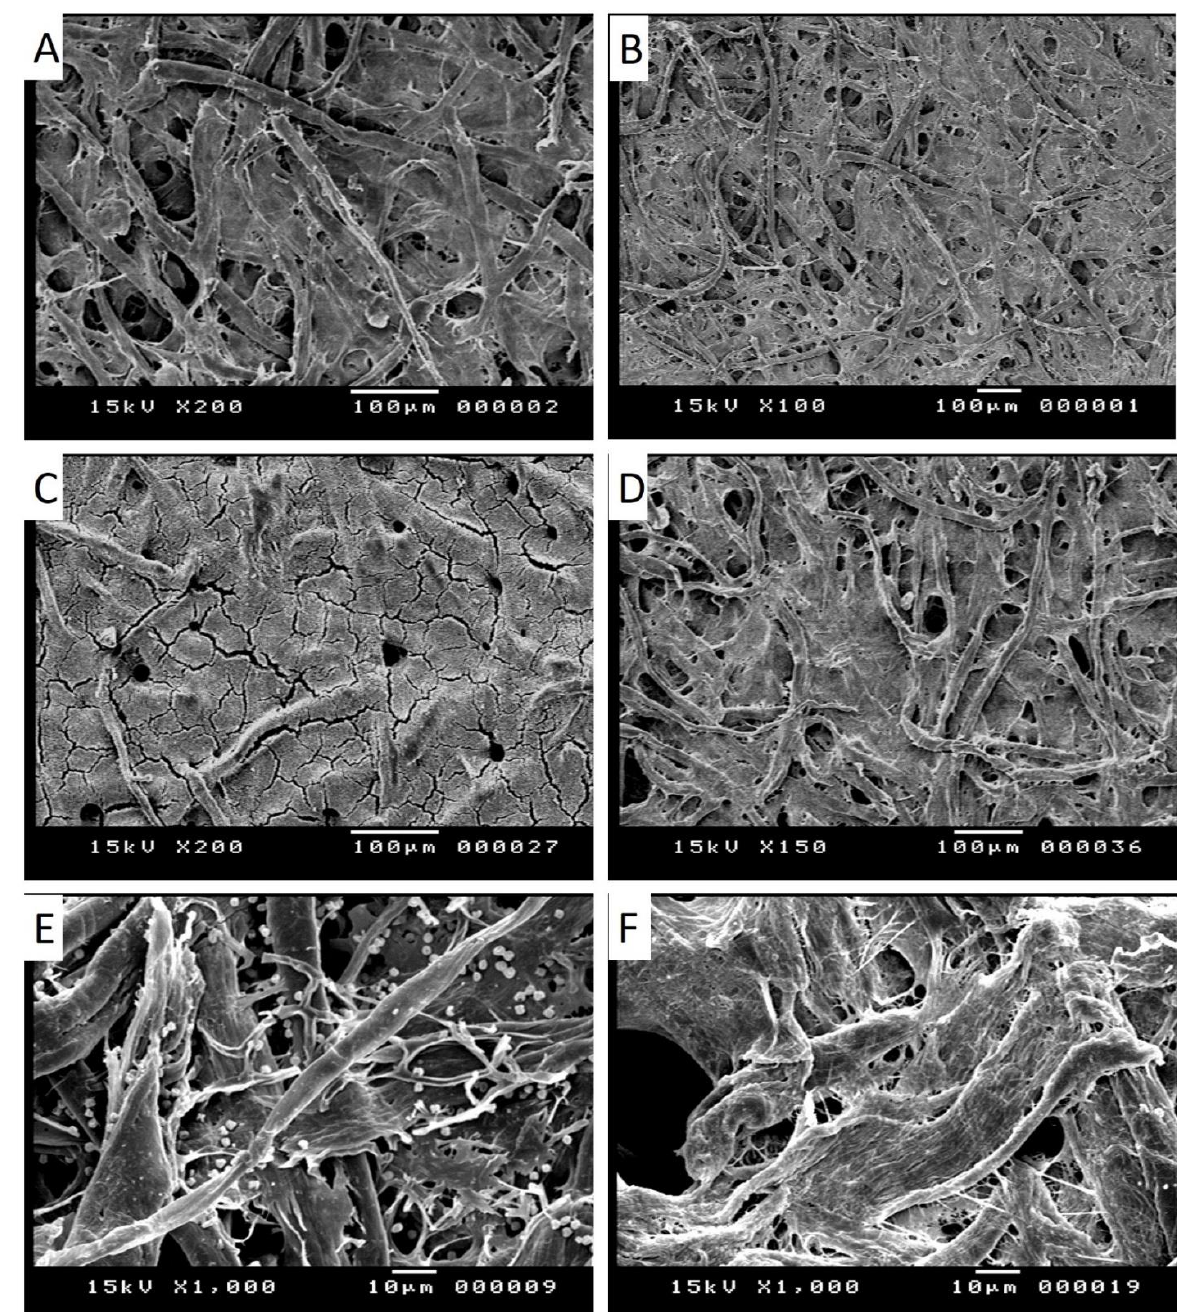
Figure 5. Scanning electron microscope (SEM) analysis of treated/untreated filter paper in the presence/absence of B. subtilis B3 and P. chrysogenum F9 after 21 aging days. ( A ) is the reference sample; ( B ) is negative control; ( C ) is untreated filter paper inoculated with B. subtilis B3; ( D ) is treated filter paper inoculated with B. subtilis B3; ( E ) is untreated filter paper inoculated with P. chrysogenum F9, and ( F ) is the treated filter paper inoculated with P. chrysogenum F9.